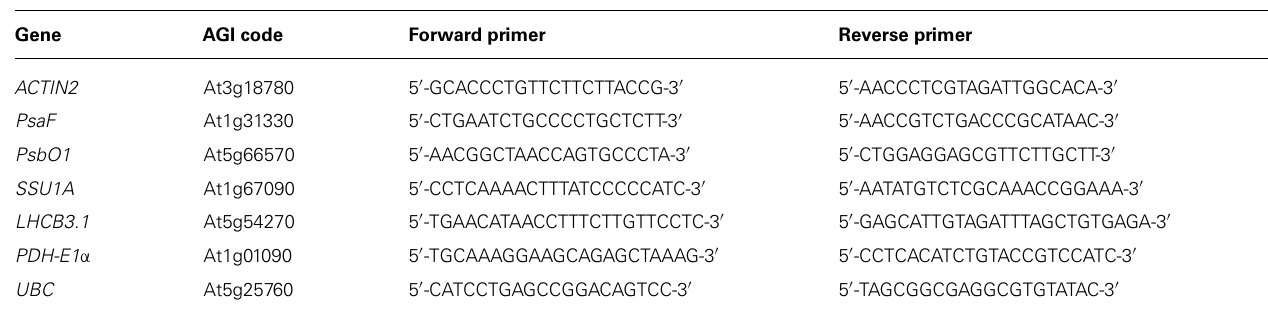
Table 1 | List of gene-specific primers used in real-time PCR analysis.